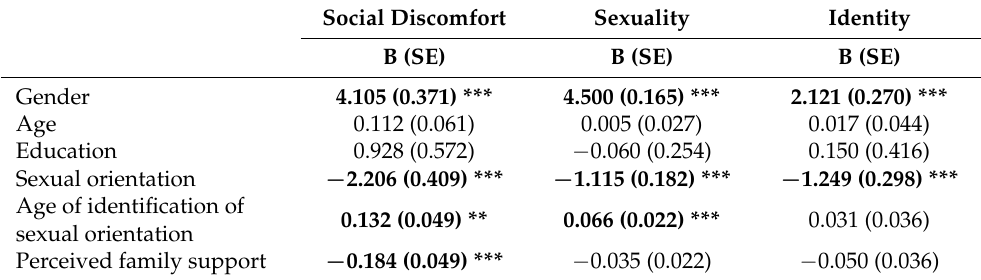
Table 2. Factors related to internalized sexual stigma: Multivariate linear regression analysis.